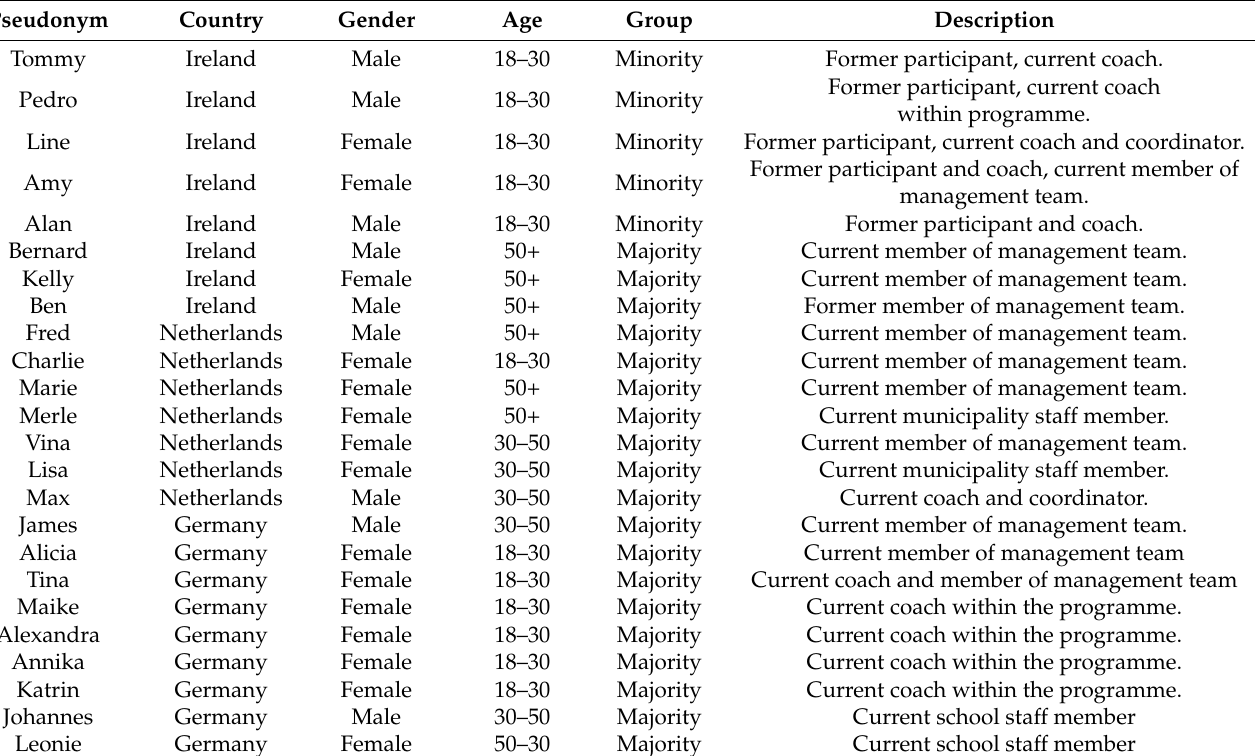
Table 1. Overview and description of interview